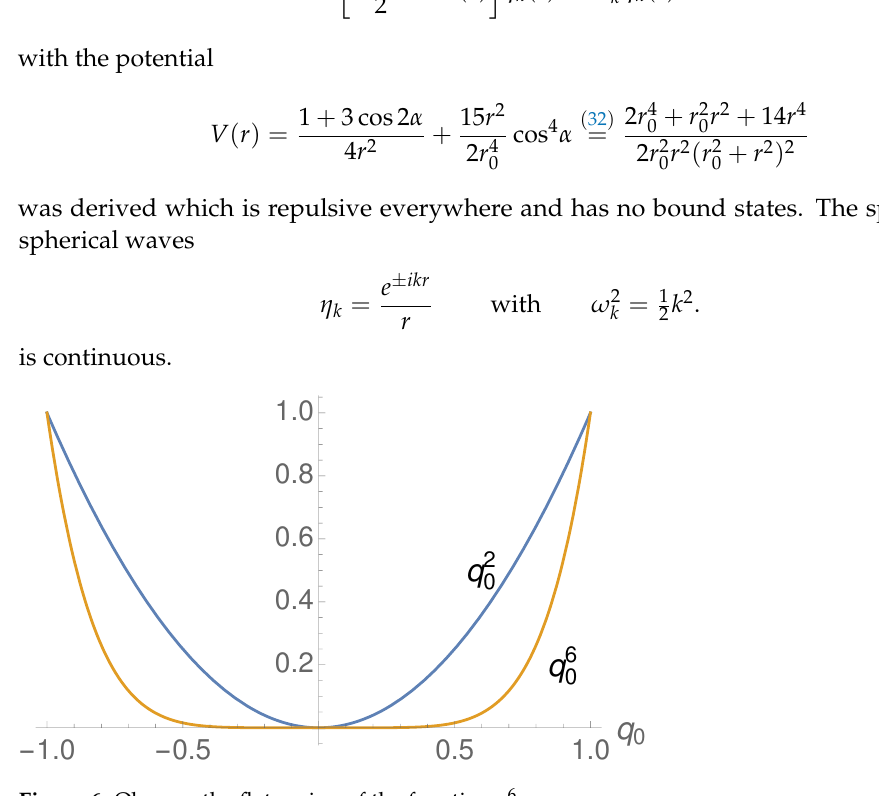
Figure 6. Observe the flat region of the function q 6